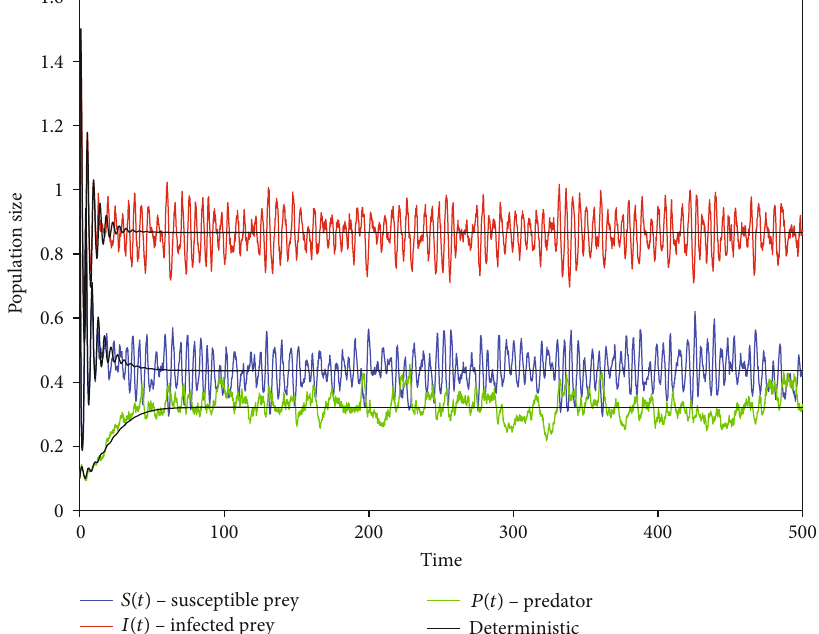
Figure 6: Simulation showing that the solution curves of both deterministic system (11) and corresponding stochastic system (23) are = 0 : 05, σ = 0 : 04, σ = 0 : 06 . permanent with σ 1 2 3